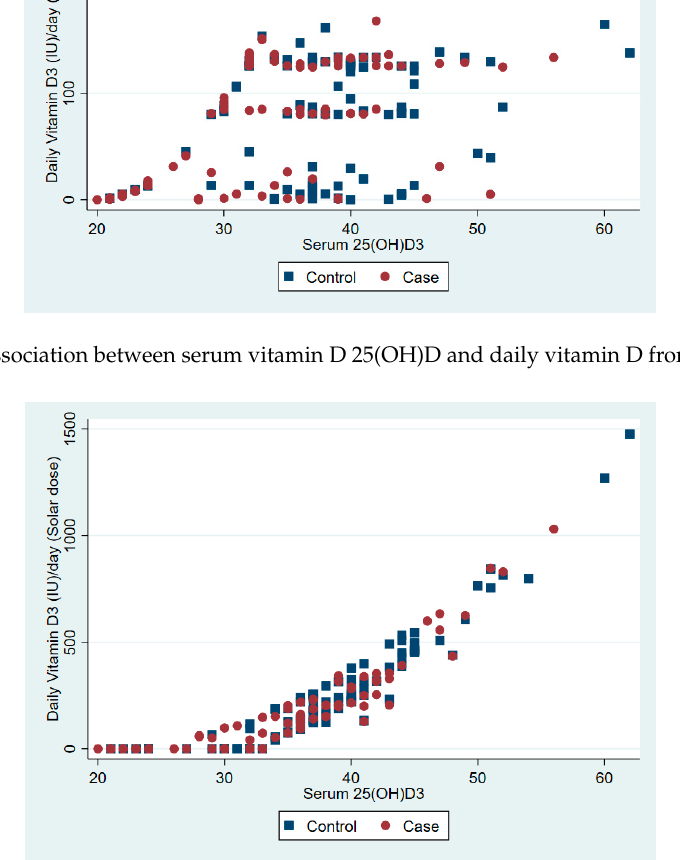
Figure 2. The association between serum vitamin D 25(OH)D and daily vitamin D from solar ultraviolet B.